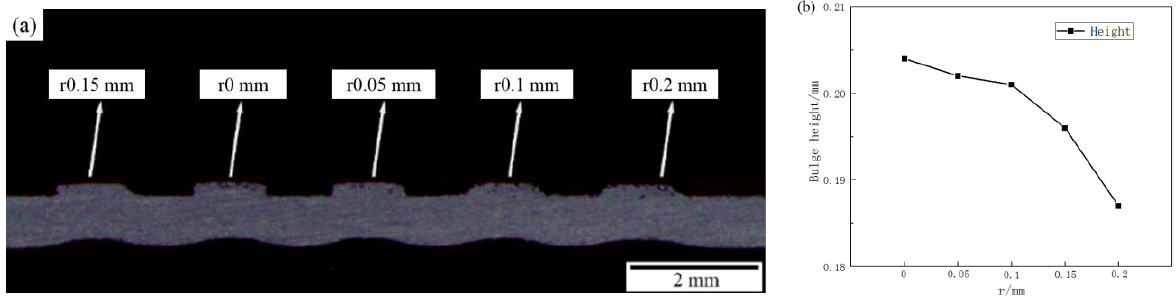
Figure 11. Cross-sectional observation of the tube deformation zone under different initial clearance